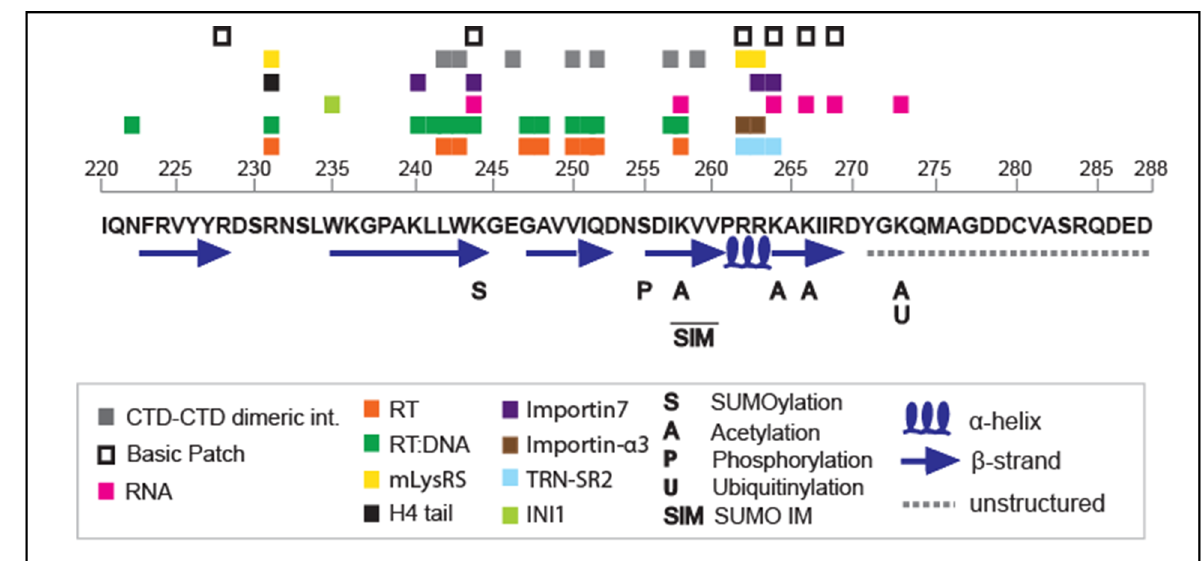
Figure 6. Scheme indicating the IN CTD amino acid residues involved in various interactions and post-translational modifications. The amino numbering is indicated above the IN CTD sequence, between aa 220 and 288. The coloured squares indicate the residues involved in the interaction of IN CTD with: RNA in dark pink [7,46]; RT and RT:DNA complex in orange and dark green [70,71]; Human Mitochondrial Lysyl-tRNA Synthetase in yellow [75]; histone H4 tail in black [76]; Importin 7 and α 3 in violet and brown, respectively [6,77–79]; TRN-SR2 in light blue [80,81]; and INI1 in light green [82]. The residues involved in CTD-CTD dimerization are labelled with grey squares, and the residues belonging to the basic patch with empty squares. Several post-translational modifications are labelled: S is for SUMOylation [50]; A for acetylation [47,49,55]; P for phosphorylation [65]; U for ubiquitination [64] and SIM for SUMO-interacting motif [63]. Elements of secondary structure are also represented at the bottom of the sequence.